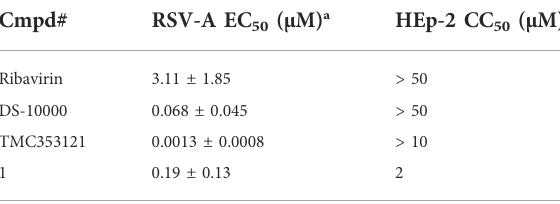
TABLE 1 Anti-RSV activity of reference and hit compounds.